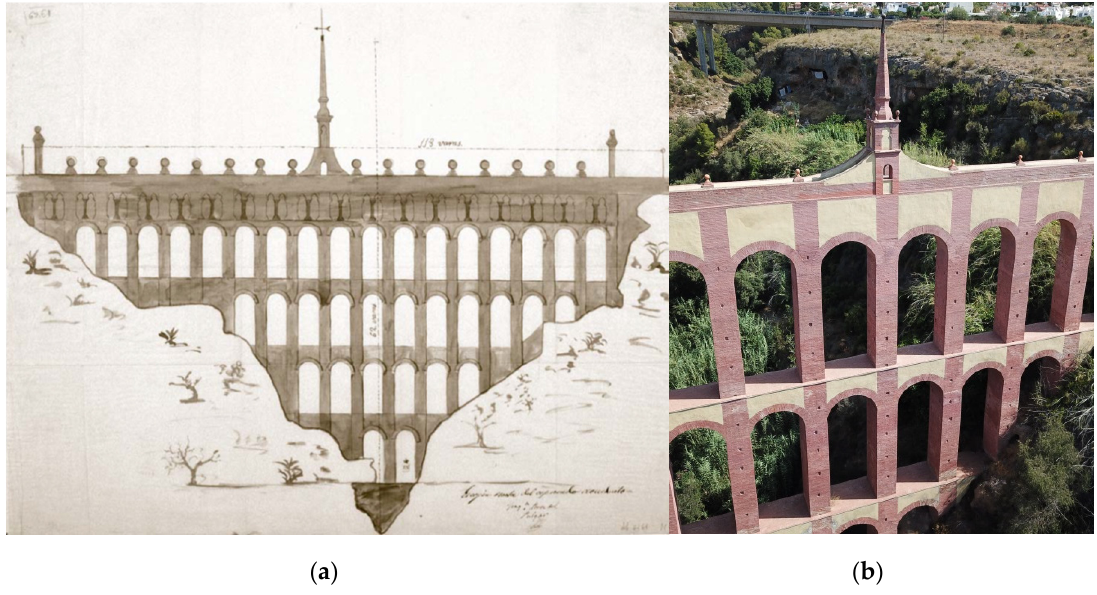
Figure 6. Aqueduct of the Aguila ( a ) Aqueduct design [56]; ( b ) Aerial photograph.